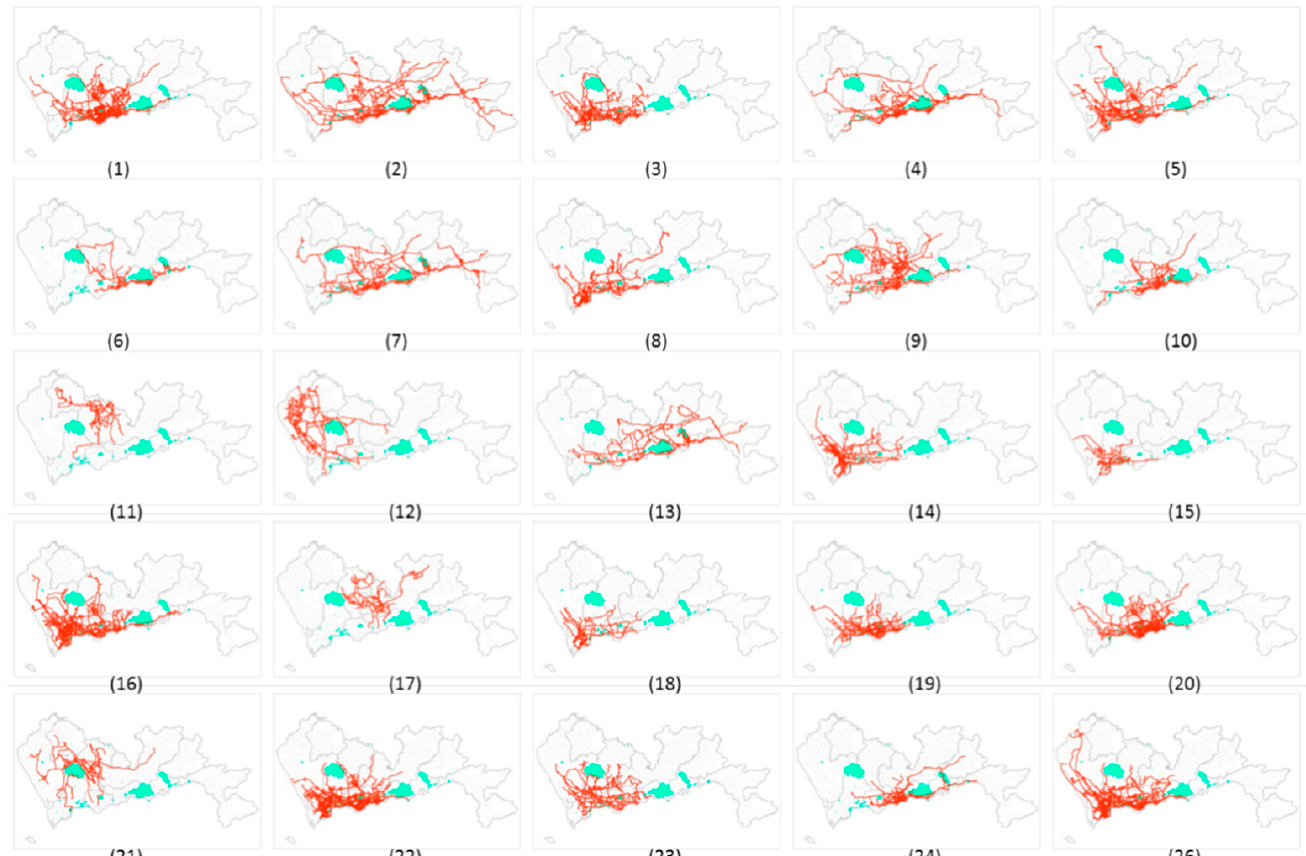
Figure 9. Travel networks for tourist attractions.